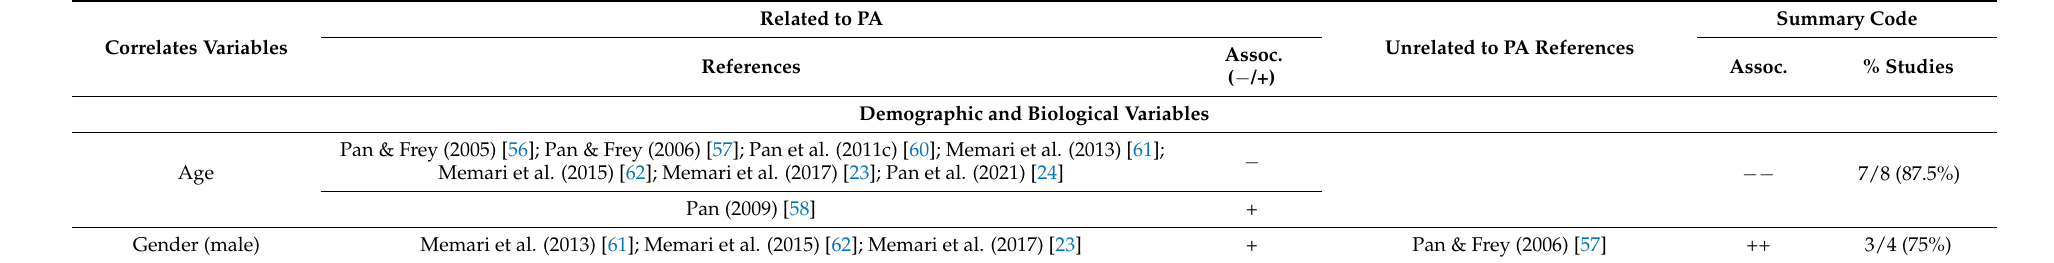
Table 2. Summary on correlates of PA of children and adolescents with ASD ( n